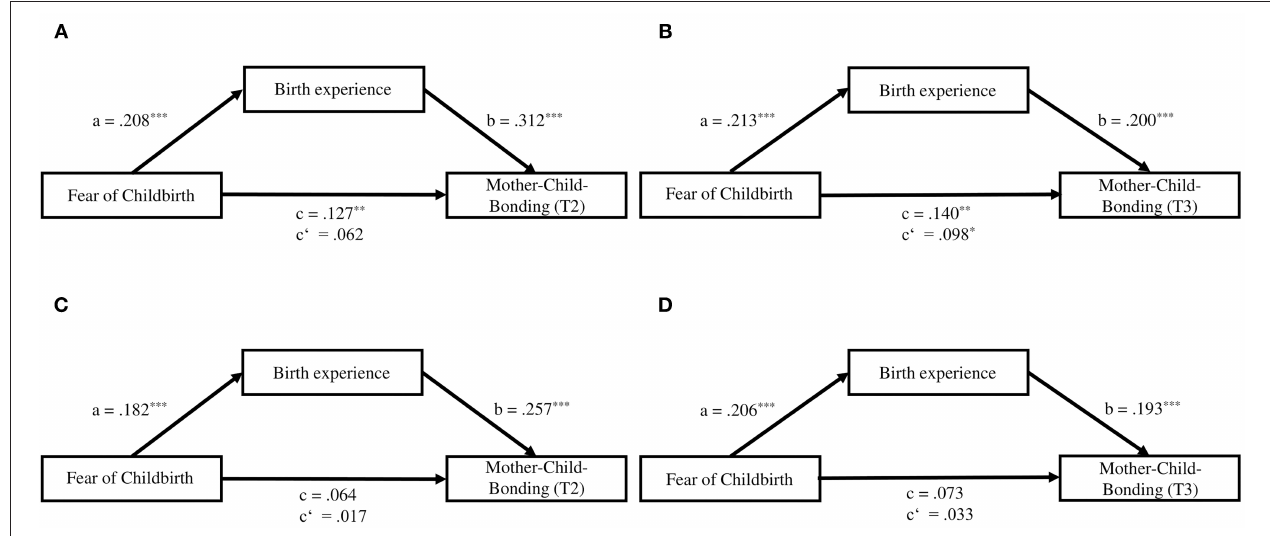
FIGURE 2 | (A) Standardized regression coefficients for the association between fear of childbirth, birth experience, and mother-child-bonding at T2. (B) Standardized regression coefficients for the association between fear of childbirth, birth experience, and mother-child-bonding at T3. (C) Standardized regression coefficients for the association between fear of childbirth, birth experience, and mother-child-bonding at T2, controlling for maternal education, parity, prepartum depressive symptoms, and birth complications. (D) Standardized regression coefficients for the association between fear of childbirth, birth experience, and mother-child-bonding at T3, controlling for maternal education, prepartum depressive symptoms, financial hardship, and partnership satisfaction. c, total effect; c’, direct effect. * p < 0.05. ** p < 0.01. *** p <